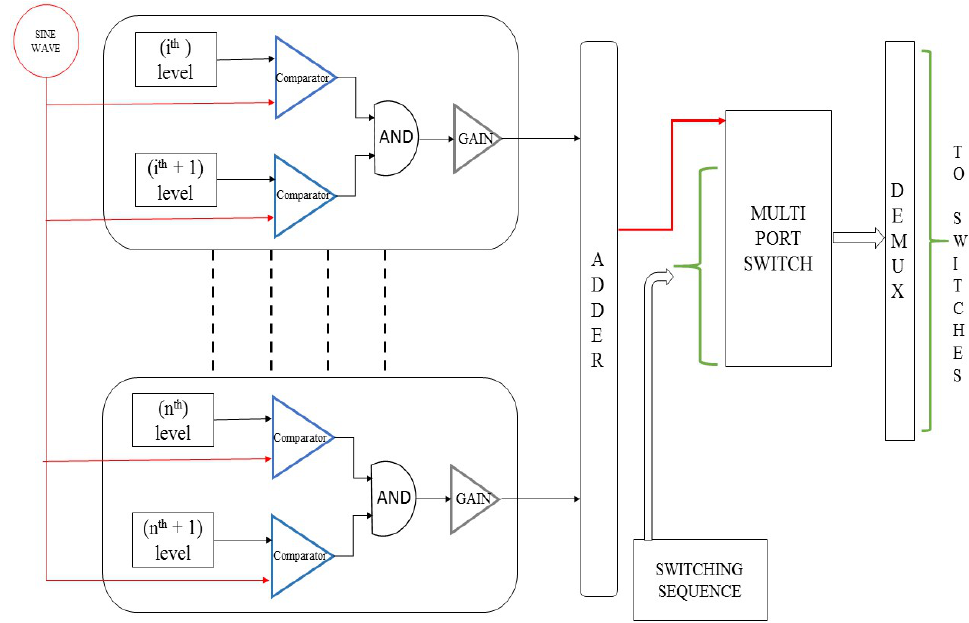
Figure 3. Block diagram for pulse generation.